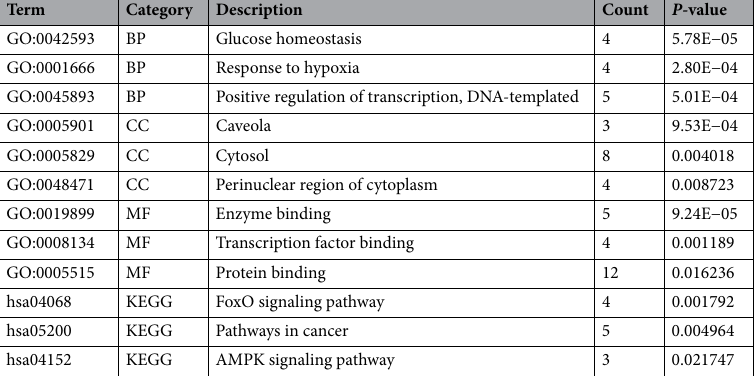
Table 3. The significant gene ontology terms of the established modules. GO gene ontology, BP biological processes, CC cellular composition, MF molecular function, KEGG Kyoto encyclopedia of genes and genomes.